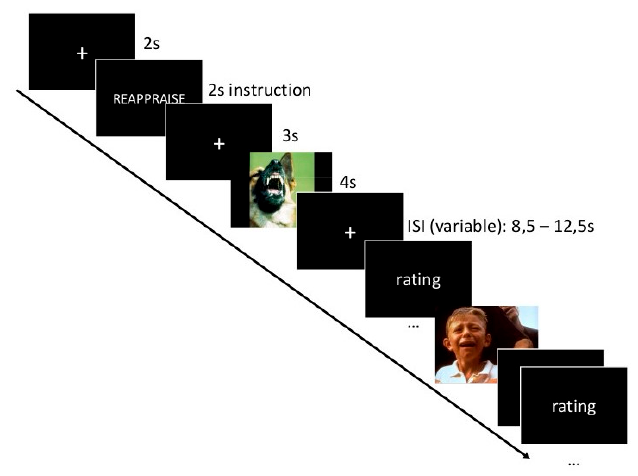
Figure 1. Paradigm: Trial presentation.